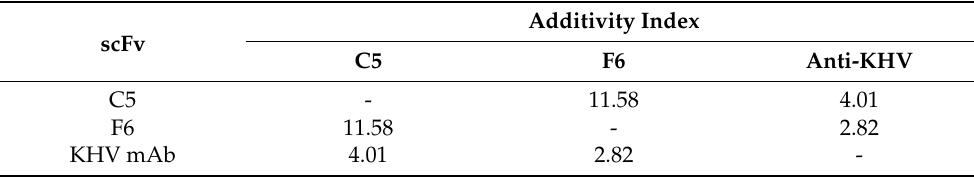
Figure 5. ( a ) Diagram of the competitive ELISA. ( b ) The affinity of F6, C5, and KHV mAb was compared to the same amount of cocktail antibody (400 ng single protein, 200 ng/200 ng combination) to perform epitope mapping of the antibody by competitive ELISA. The correlation between groups was measured statistically (** p = 0.0051; **** p < 0.0001; ns, nonsignificant). The results are shown as an additivity index in Table 5. ( c ) Comparison of affinity values determined by competitive ELISAs with different amounts of one protein in the total mixture demonstrates different interaction effects (* p = 0.0298; **** p < 0.0001; ns, nonsignificant). ( d ) Affinity measurements for F6, C5, and KHV mAb were determined by sandwich ELISAs. ( e ) Quantitative analysis of sandwich ELISAs demonstrates that the F6 and C5 interactions are more favorable for detecting KHV virions than combinations with the commercial KHV mAb. Data are presented as the mean ± SEM. Table 5. Additivity index values obtained using competitive